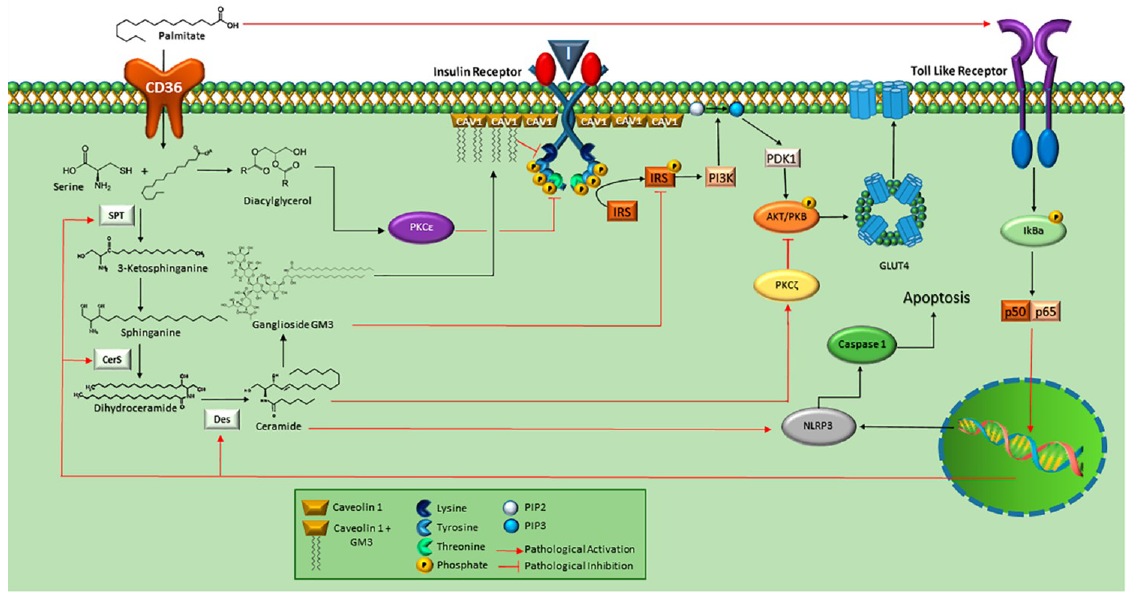
Figure 1. Metabolic implications associated to ceramide synthesis. Free fatty acid (FFA) such as palmitic acid is internalized through CD36, and ceramide synthesis is stimulated by serin-palmitoyl acyltransferase (SPT) through the addition of serine to produce sphinganine. Then, is converted into dihydroceramide by CerS and finally to ceramide by Des. Ceramides promote inhibition of Akt/PKB signaling by PKC function. Ceramides can be turned to GM3 which inhibits INRS, blocking insulin signaling. GM3 accumulation promotes the dissociation of IR/Cav-1 complex. Likewise, palmitic acid can function as a ligand for TLR-4, activating its signaling cascade that leads to the expression of genes encoding enzymes such as SPT, CerS, and Des. On the other hand, palmitic acid can be metabolized to DAG, which stimulates PKCε, activated PKCε phosphorylates Thr 1160 of INSR, causing its inhibition. Finally, ceramides could activate NLRP3 and lead to apoptosis by Caspase-1-dependent pathway. Image adapted from references: